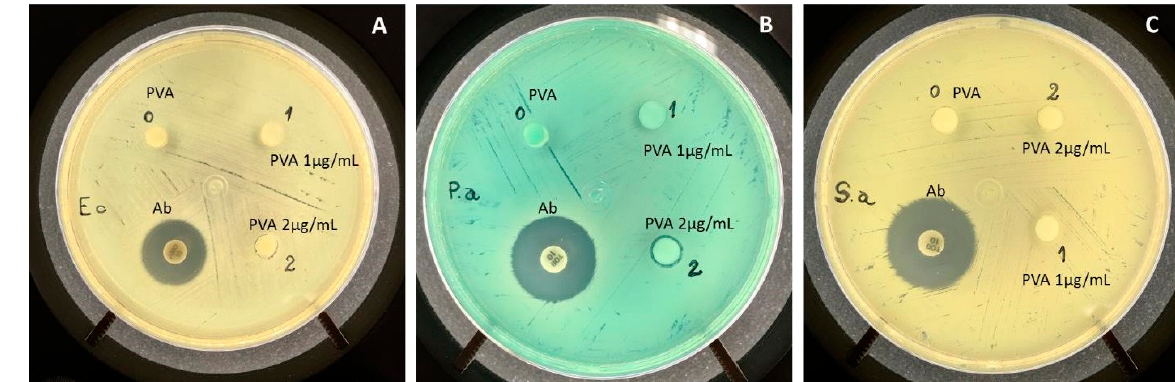
Figure 3. The antimicrobial activity of the PVA containing or not two concentrations of AgNP (1 and 2 µ g/mL) was evaluated in the different bacterial species: ( A ) Escherichia coli ; ( B ) Pseudomonas aeruginosa , and ( C ) Staphylococcus aureus . The Ab halo formation is represented by the standard antibiotic positive control.